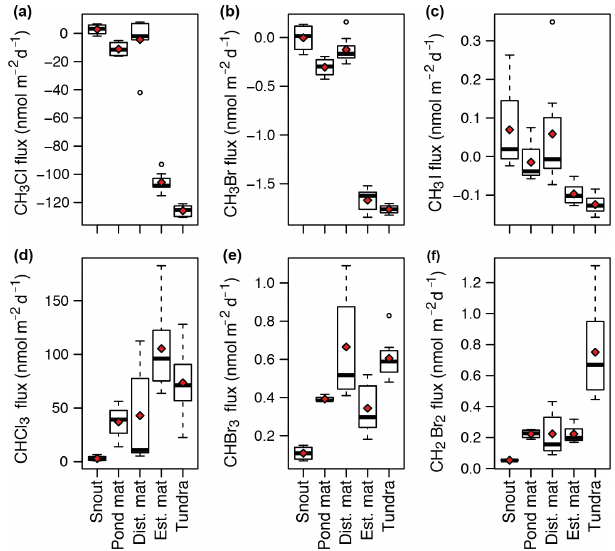
Figure 5. Daily fluxes (nmolm − 2 d − 1 ) at each site of CH 3 Cl (a) , CH 3 Br (b) , CH 3 I (c) , CHCl 3 (d) , CHBr 3 (e) , and CH 2 Br 2 (f) . Red diamonds represent the mean flux for each site. “dist. mat” is the disturbed mat site; “est. mat” is the established mat